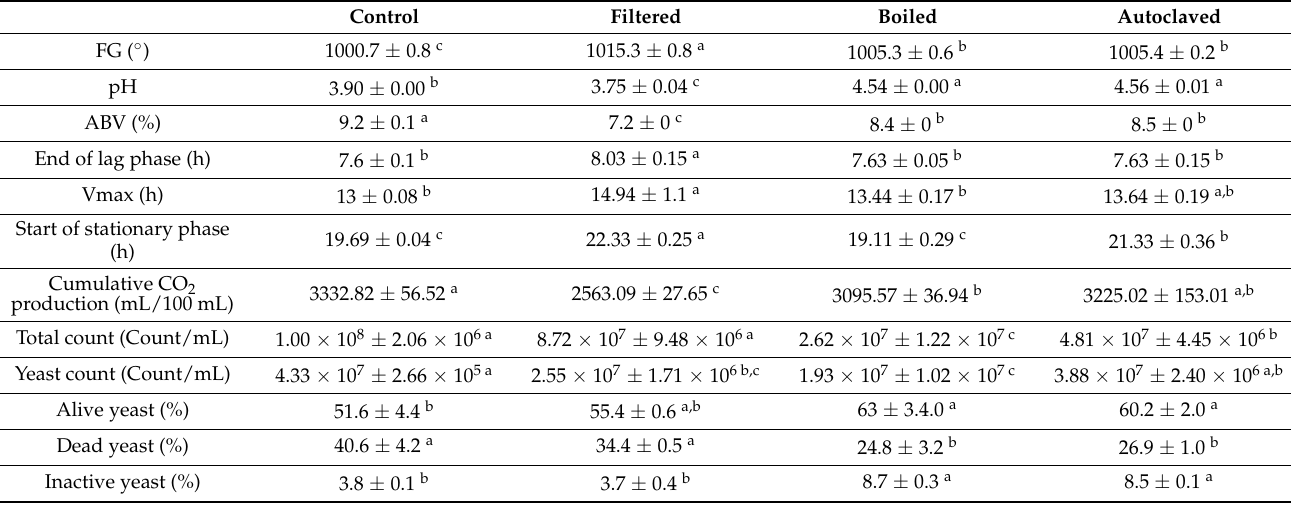
Figure 1. Flow cytometer particle count for the forward scatter (FSC) and the sideward scatter (SSC) for four different worts: CW, control wort; FW, filtered wort; BW, boiled wort; and AW, autoclaved wort. Table 1. Average and standard deviations of fermentation parameters after fermentation for three pretreatment conditions for wort compared to a control wort. Letters (a, b, c) indicate significant differences ( p < 0.05).